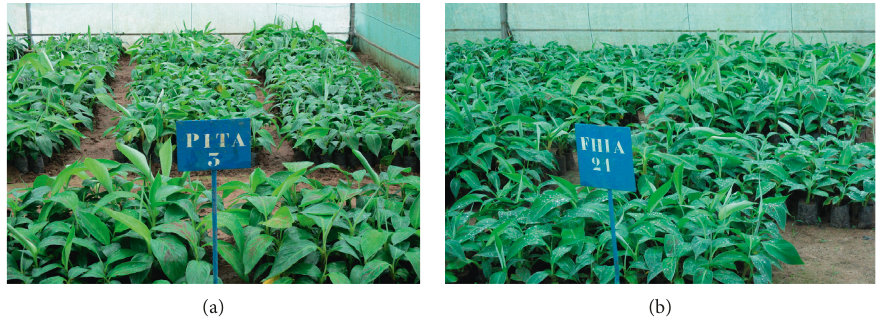
Figure 3: Seedlings of PITA 3 and FHIA 21 grown in the nursery prior to distribution and field transplanting in Cˆote d’Ivoire.